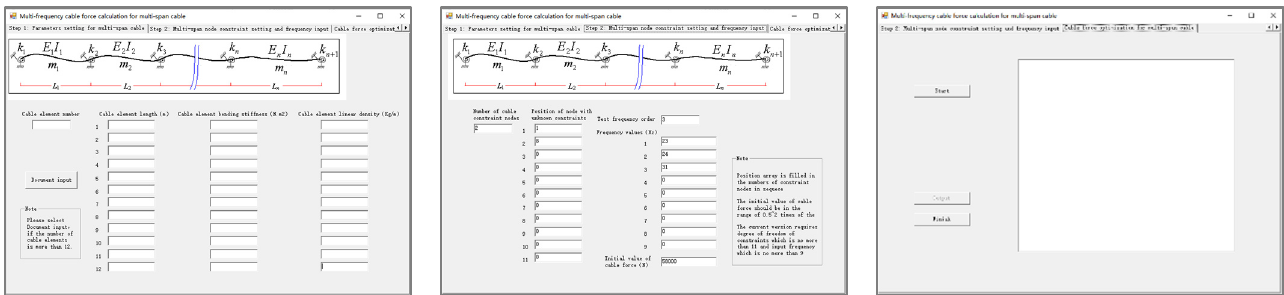
Figure 22. Multi-span cable force calculation.